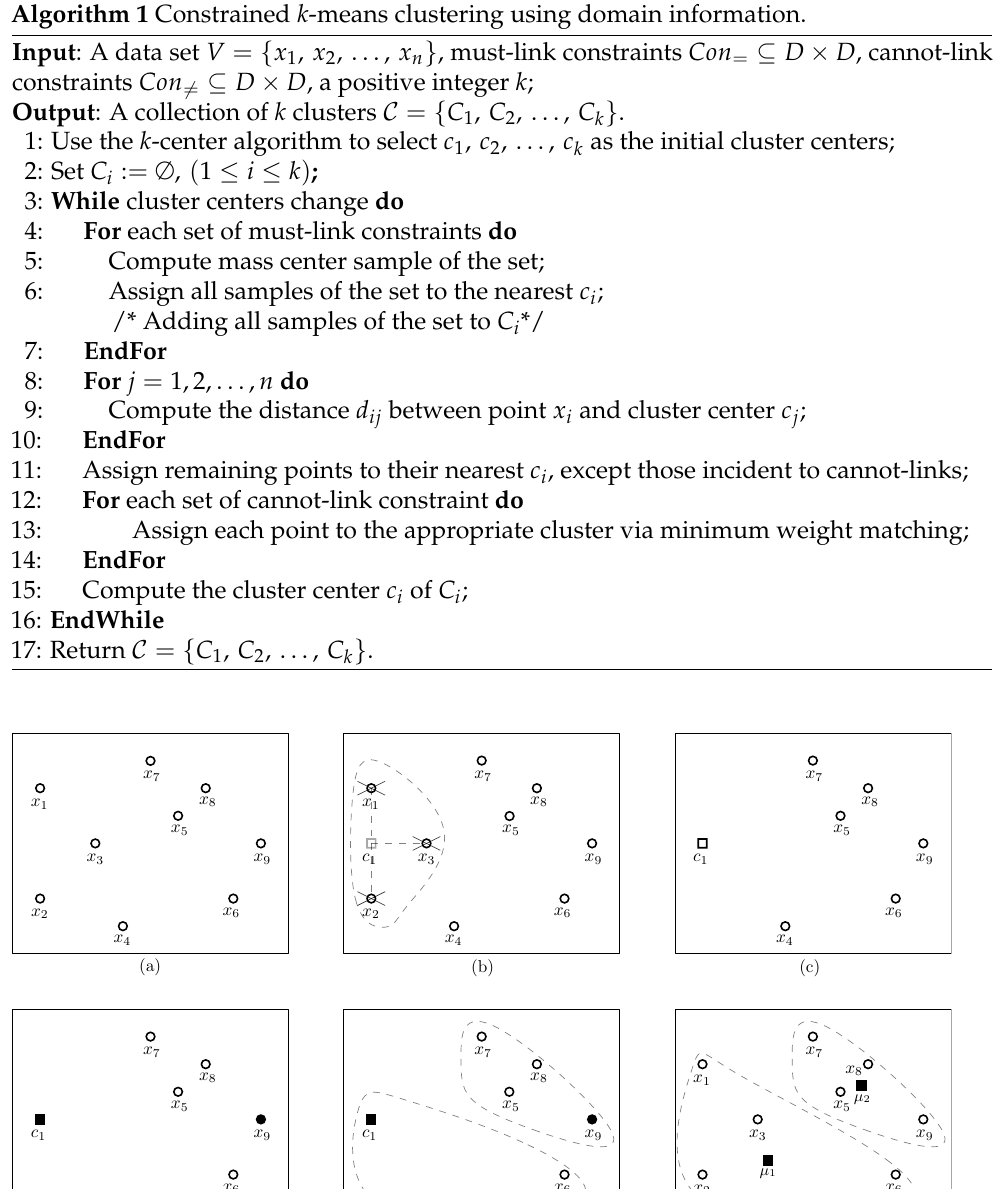
Algorithm 1 Constrained k -means clustering using domain information.